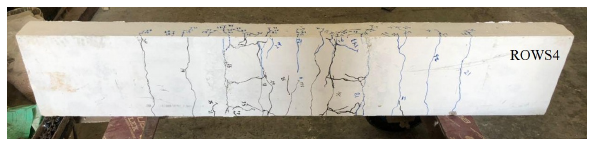
Figure 17: Bottom crack pattern of slab ROWS4.